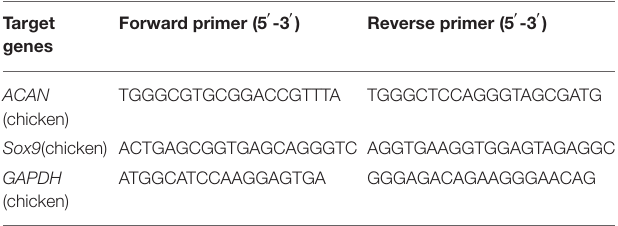
TABLE 2 | Primer sequences of target